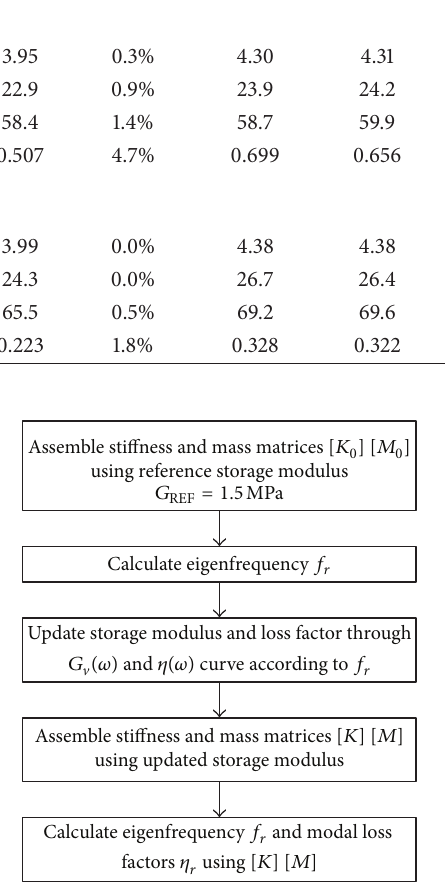
Figure 6: Flowchart illustrating the 𝑟 th modal loss factor calcula-